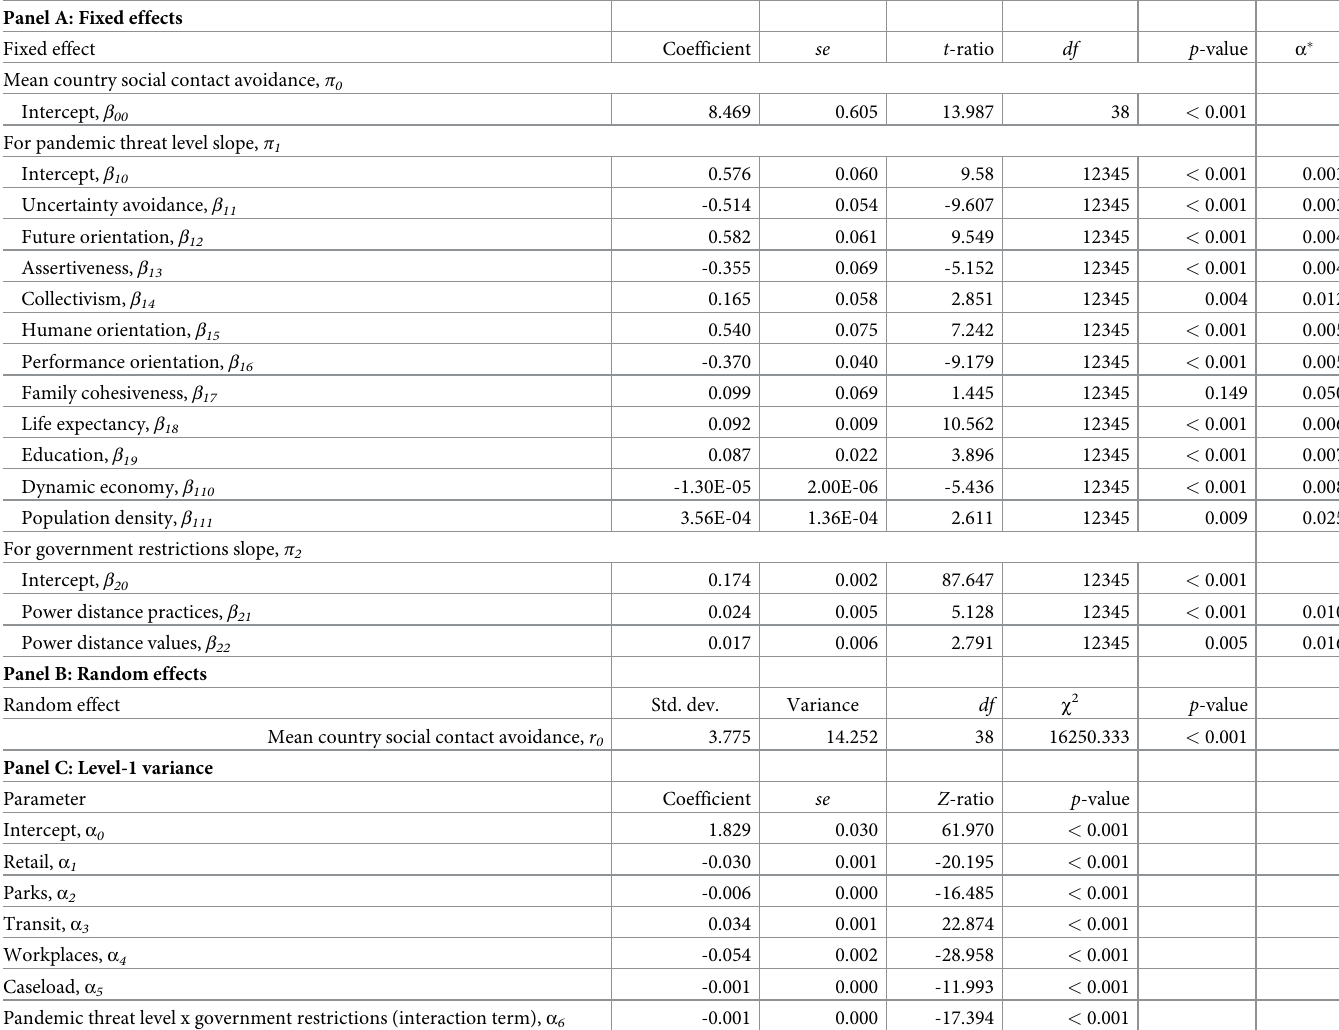
Table 3. Effects in the HLM contextual